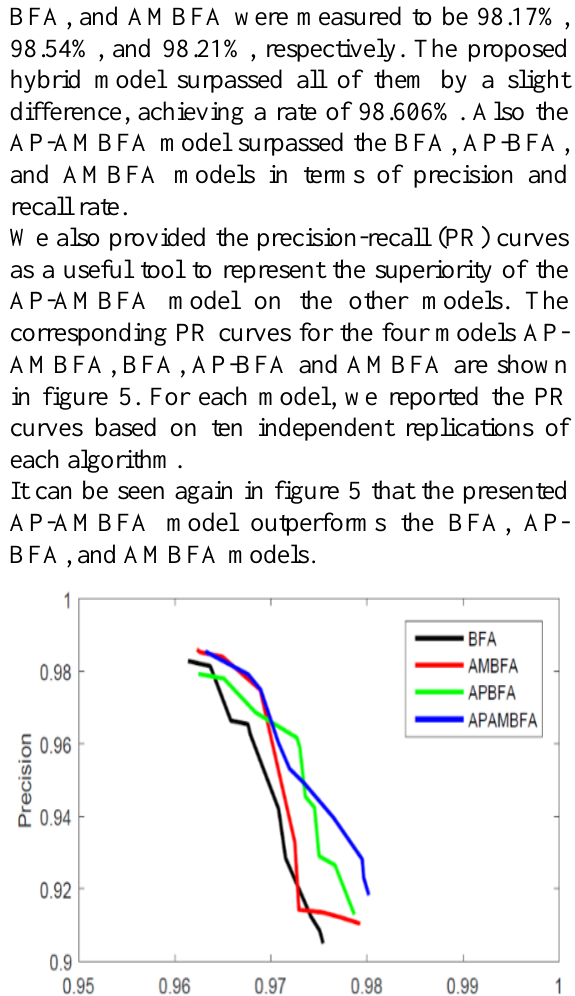
Figure 5. PR curves for four different